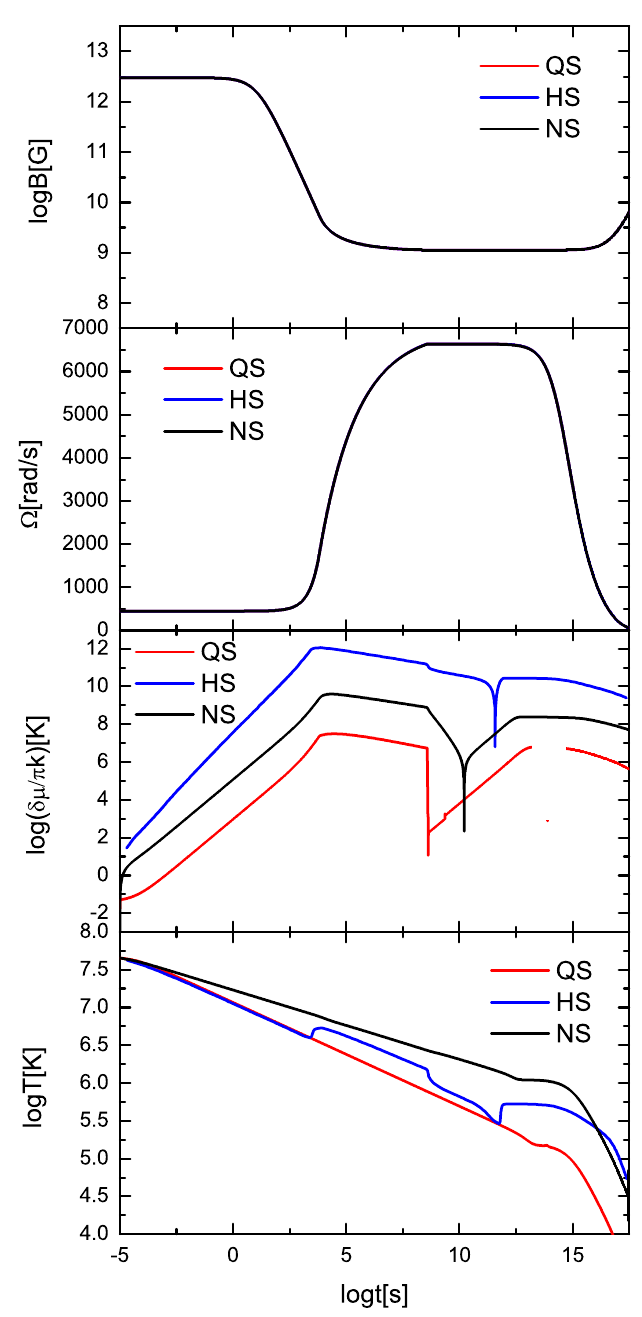
Figure 3. Surface magnetic field, spin angular frequency, chemical deviation, and surface temperature as a function of time with parameters of model 3. Pure neutron star, pure quark star, and hybrid star are represented by black line, red line, and blue line, respectively. The units of the temperature, chemical deviation, magnetic field, spin angular frequency, and time are K, K, G, rad/s, and s,